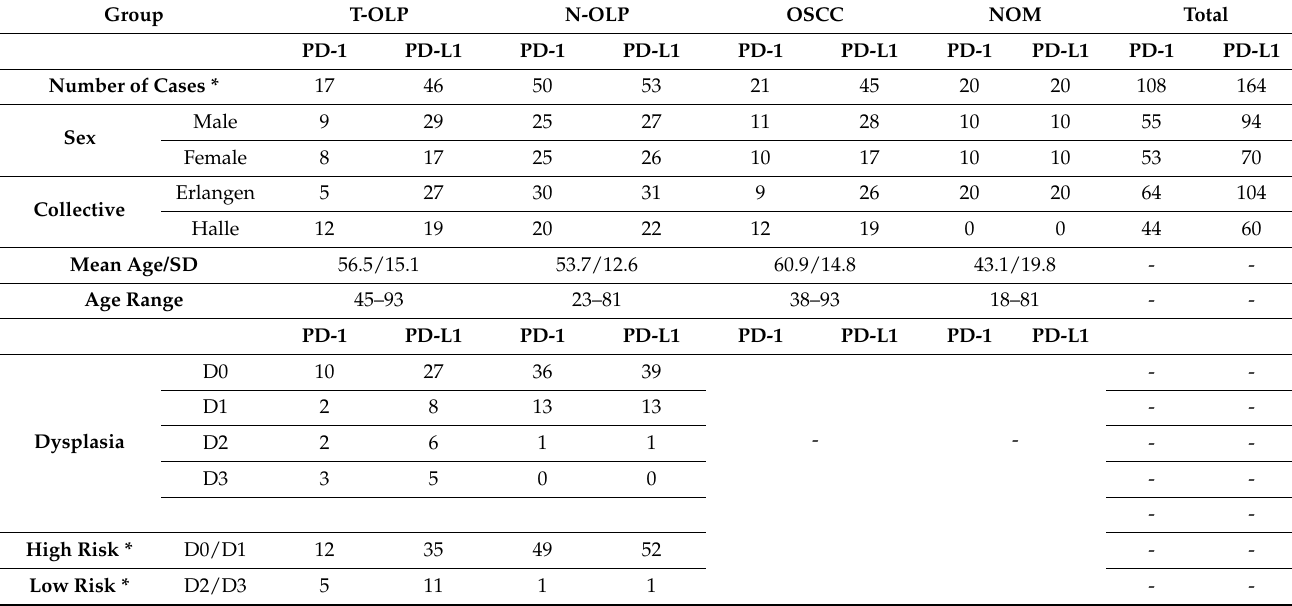
Table 2. Demographic, clinical and histopathological characteristics of the histological patients’ collective used in immuno-